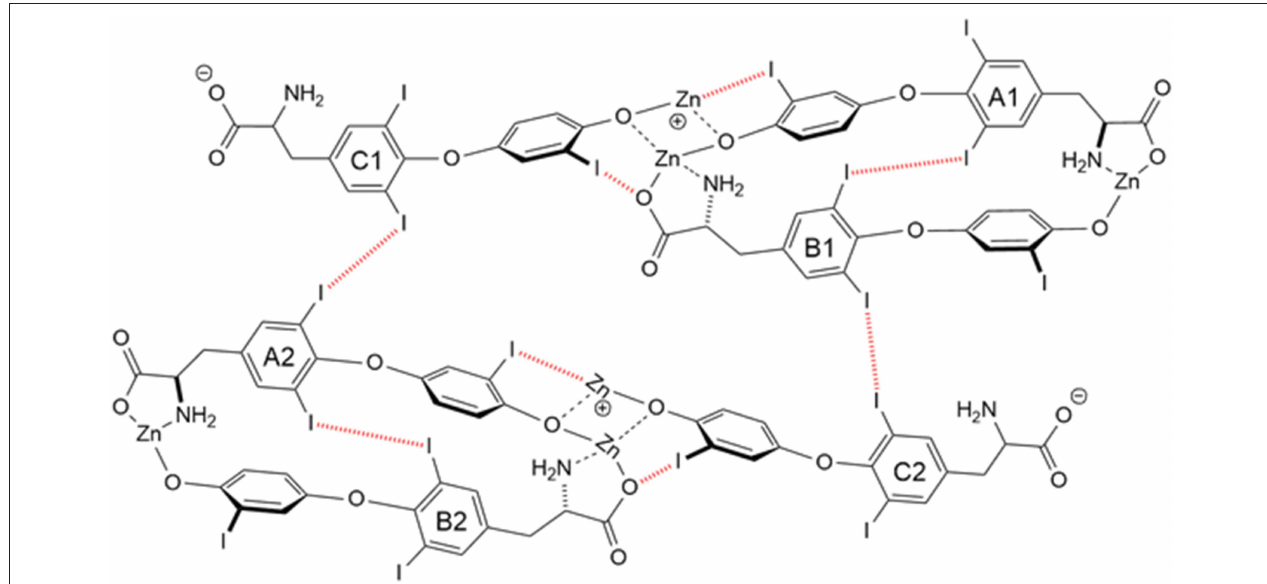
FIGURE 2 | Strong bonding interactions (coordinate covalent bonds) between Zn and ligand donor atoms of T3 2 - are shown in black; weak bonding interactions (halogen bonds) between iodine and X-bond acceptor atoms of T3 2 - are shown in red dashed line. Both bonding modes contribute to polymer formation and stabilization. Two and 3-D structures, including metal organic frameworks, are possible.